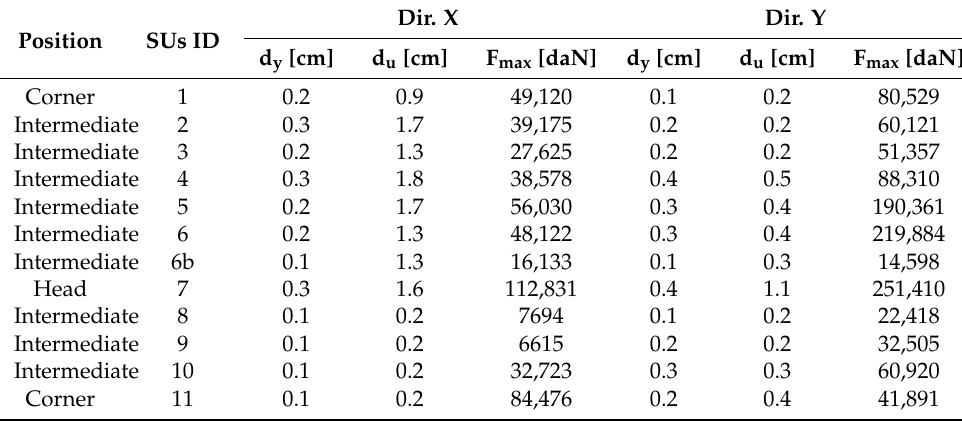
Table 4. Capacity parameters for the investigated SUs.